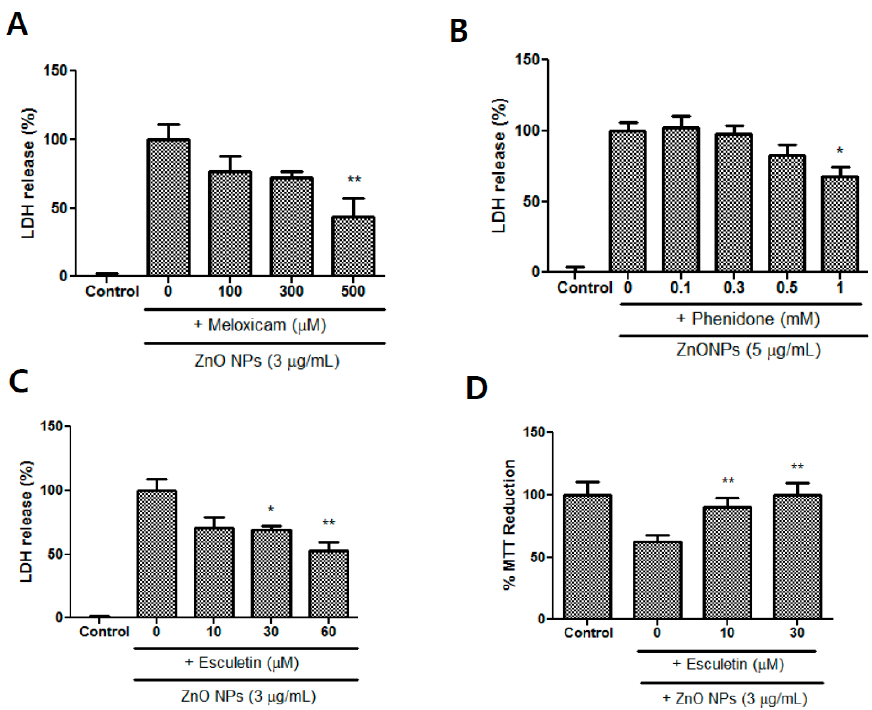
Figure 8. Protective effects of meloxicam ( A ), phenidone ( B ), and esculetin ( C , D ) against ZnO NP-induced toxicity in primary astrocyte cultures. Cytotoxicity was evaluated using LDH release ( A – C ) and MTT reduction ( D ) assays. Data represents the mean ± SEM. * p < 0.05, ** p < 0.01 compared to control ( n = 4).